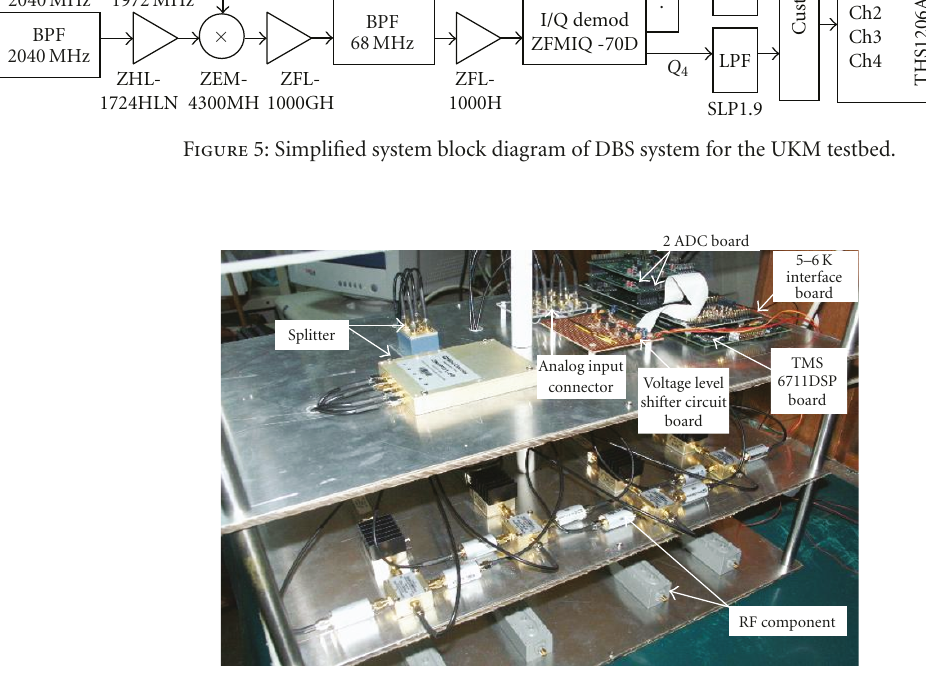
Figure 6: The developed RF front-end for UKM testbed.